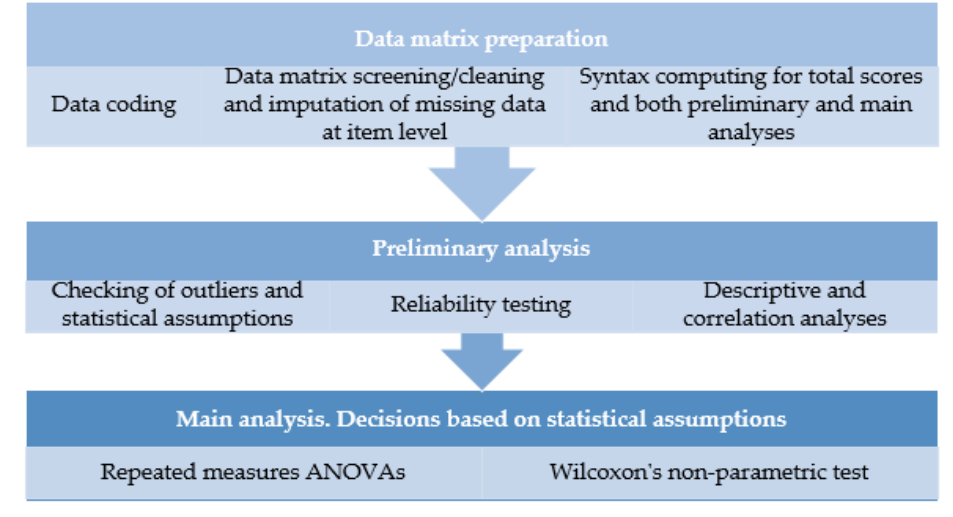
Figure 2. Steps for quantitative data analysis.